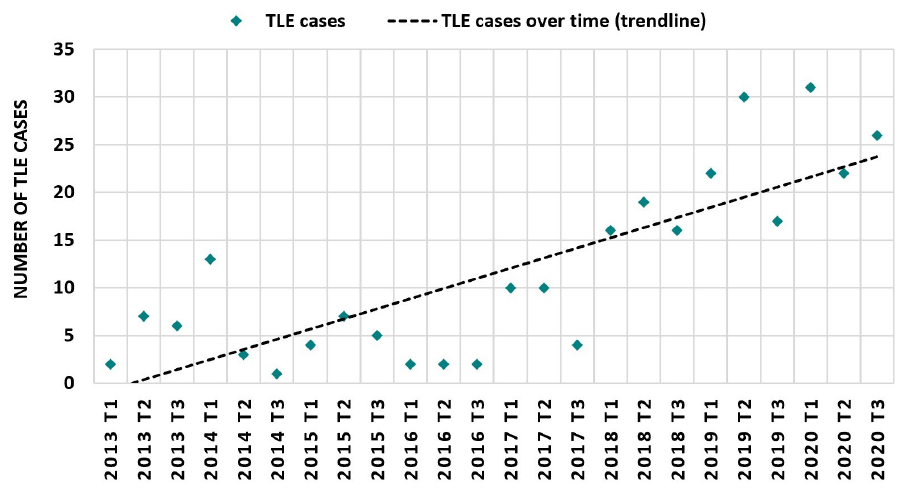
Figure 1. Number of TLE cases over time. The number of TLE cases performed at the University Hospital Zurich is depicted for each four-month period. TLE: transvenous lead extraction.